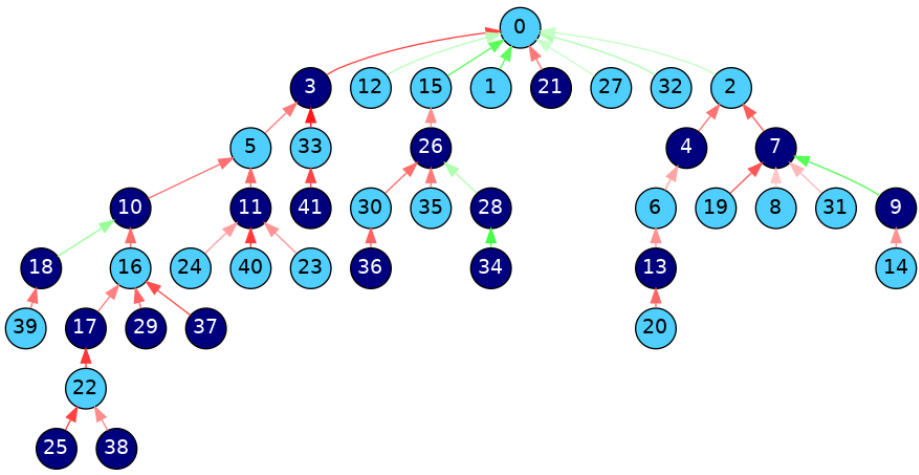
Figure 2. Two-sided debate tree for the Reddit debate of Figure